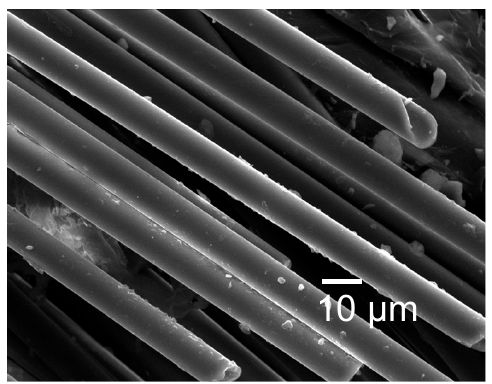
Figure 3. SEM of ‘as received’ manufacturing scrap material showing limited resin wet-out on glass fibers. This indicates the as-received material had very high fiber content, >70 wt%. Table 2. Verification of fiber weight fraction in